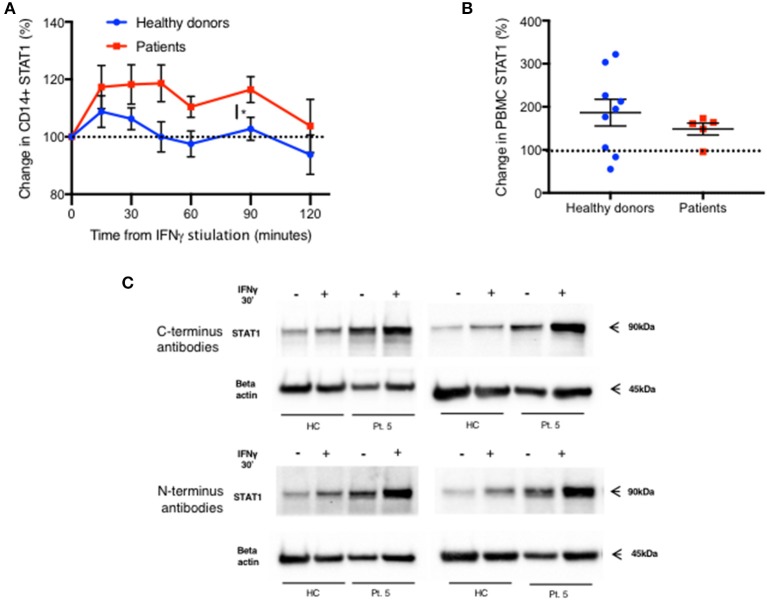
Rapid increase in STAT1 protein level after IFNγ stimulation in both patients and healthy donors. (A) Change in STAT1 protein level in CD14+ monocytes after IFNγ stimulation in healthy controls (blue line, n = 4–16 per time point) and GOF patients (red line, n = 3–10 per time point). Change is expressed in percentages from the baseline level. STAT1 level was measured using flow cytometry (B) Change in STAT1 protein level in PBMC 30 min after IFNγ stimulation in healthy controls (blue dots, n = 9) and GOF patients (red squares, n = 5). Change is expressed in percentages from the baseline level. STAT1 level was measured using immunoblotting. (C) Patient five STAT1 protein level with and without IFNγ stimulation (30′), compared to a healthy control, as measured by immunoblotting using four different antibodies targeting four different sites of STAT1 protein [two at the C-terminus and two at the N- terminus (see methods)]. The same patient sample was used on three separate membranes. *P < 0.05, by t-test. Quantitative data represent mean ± SEM (A-B).